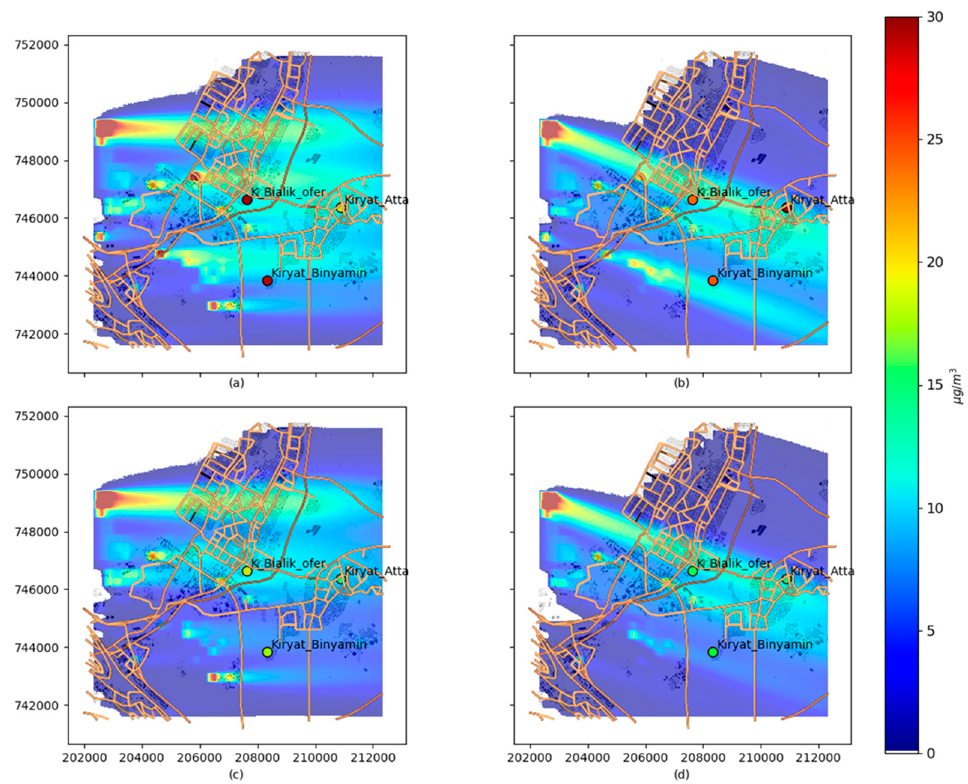
Figure 4. PM concentrations (in µ g/m 3 ) calculated by the LSM for the ground level. ( a , b ) refer to PM10 concentrations in typical morning and evening conditions, respectively. ( c , d ) are similar to ( a , b ) in terms of the meteorological conditions, but for PM2.5 concentrations. Measured PM concentrations appear in circles with color scale similar to the calculated concentrations. The map coordinates are expressed in ITM (the Israeli Transverse Mercator coordinate system).